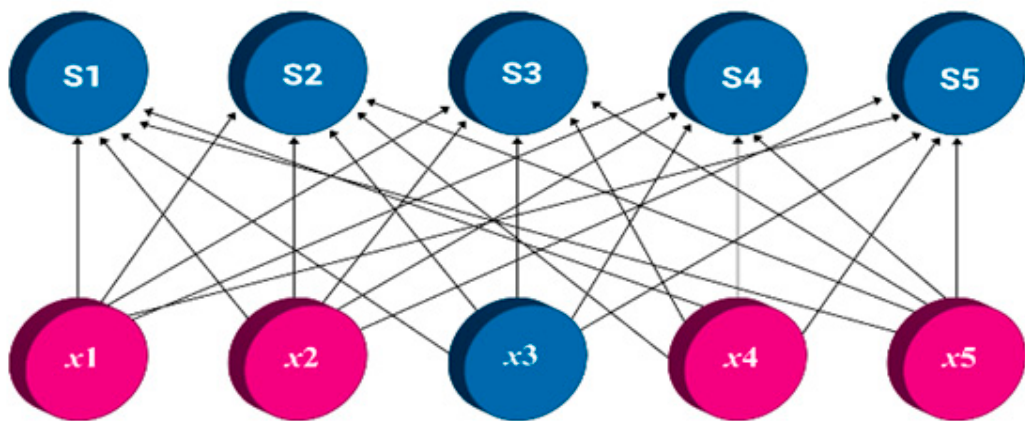
Figure 2. Part of the neural network architecture with a fully connected layer with input layer denoted by the nodes x1~x5 and the output layer denoted by S1~S5. Here, as an example, with matrix multiplication, all the outputs are affected by x3 (shown in blue).